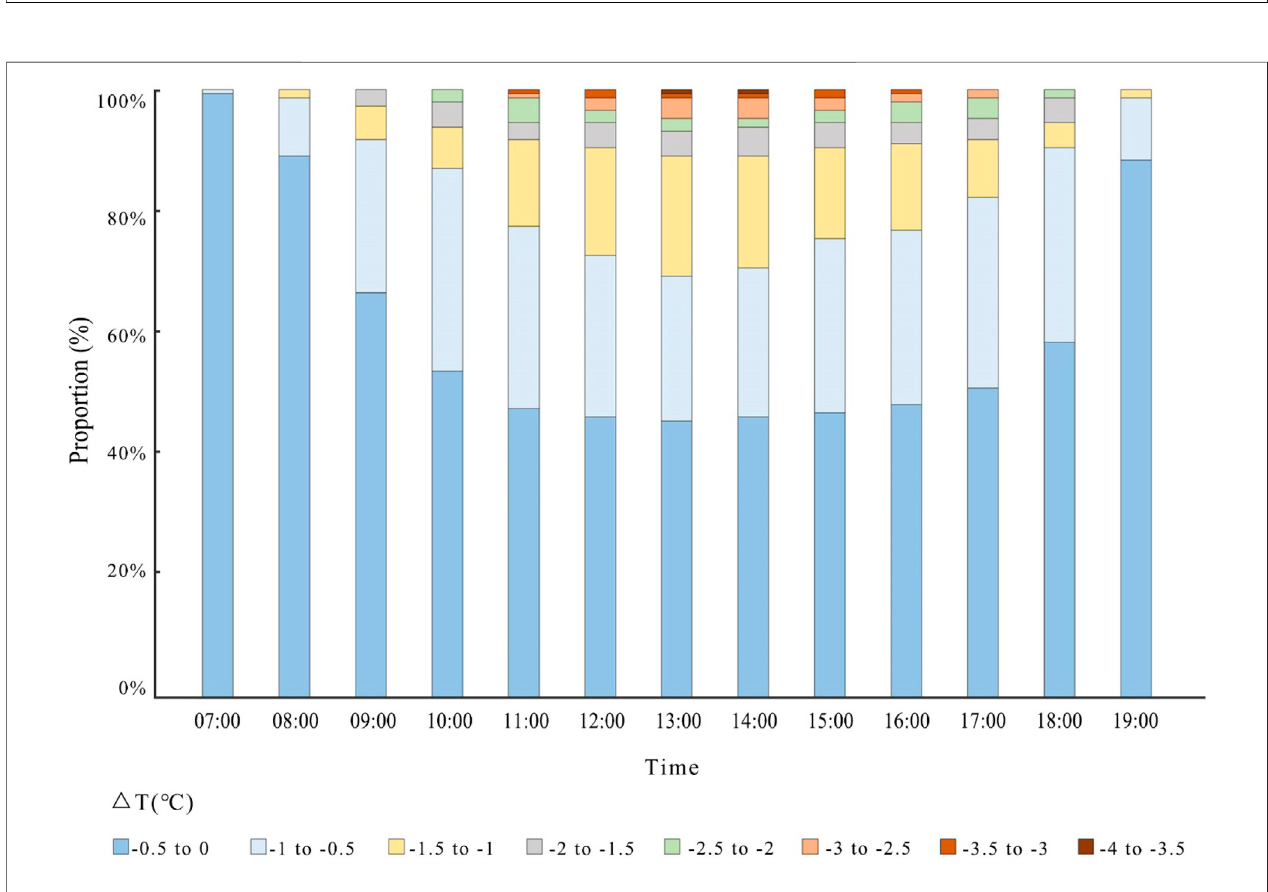
FIGURE 7 | Time-space distribution of minimum and maximum water body cooling effect.